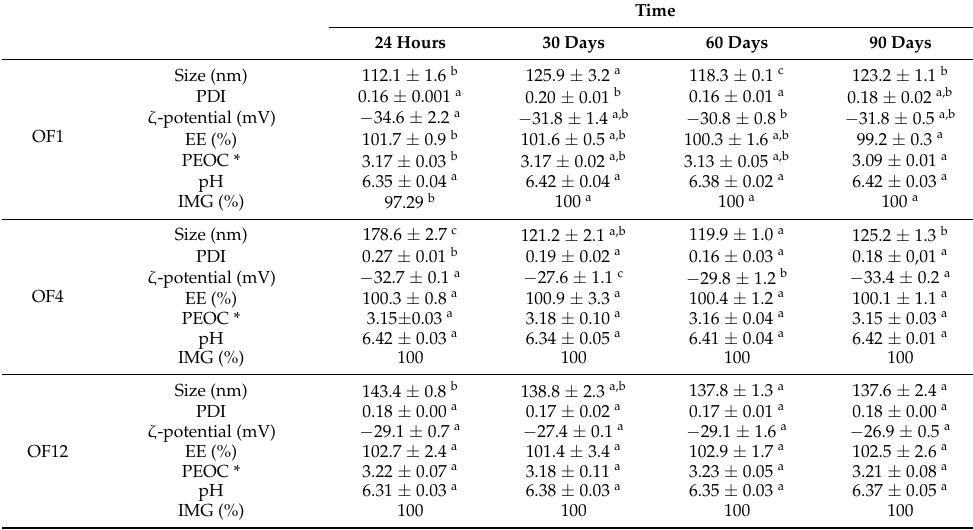
Table 5. Size, polydispersity index (PDI), zeta potential ( ζ -potential), entrapment efficiency (EE), Palmarosa essential oil content (PEOC), pH, and inhibition of mycelial growth (IMG) of the optimized formulations (OFs) after 24 h, 30 days, 60 days, and 90 days of storage at room